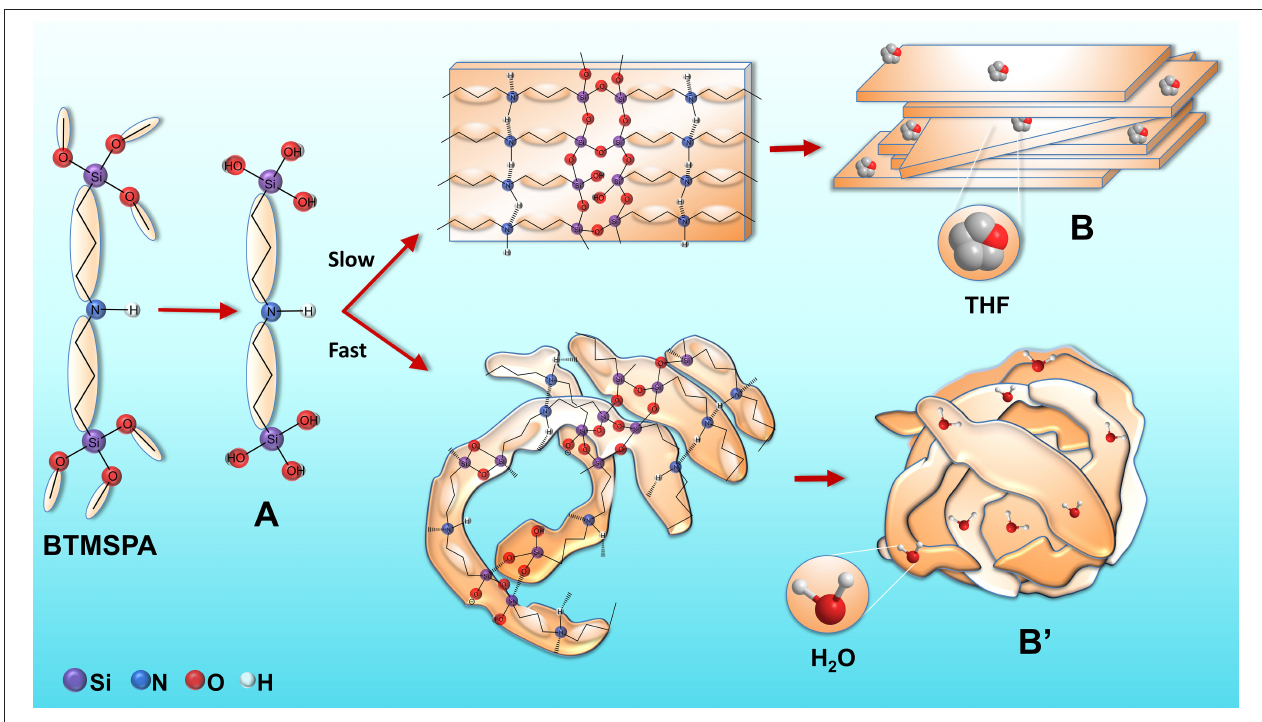
FIGURE 8 | Mechanistic scenario for the synthesis of the BS-1 (top) and BS-4 (bottom) hybrids.